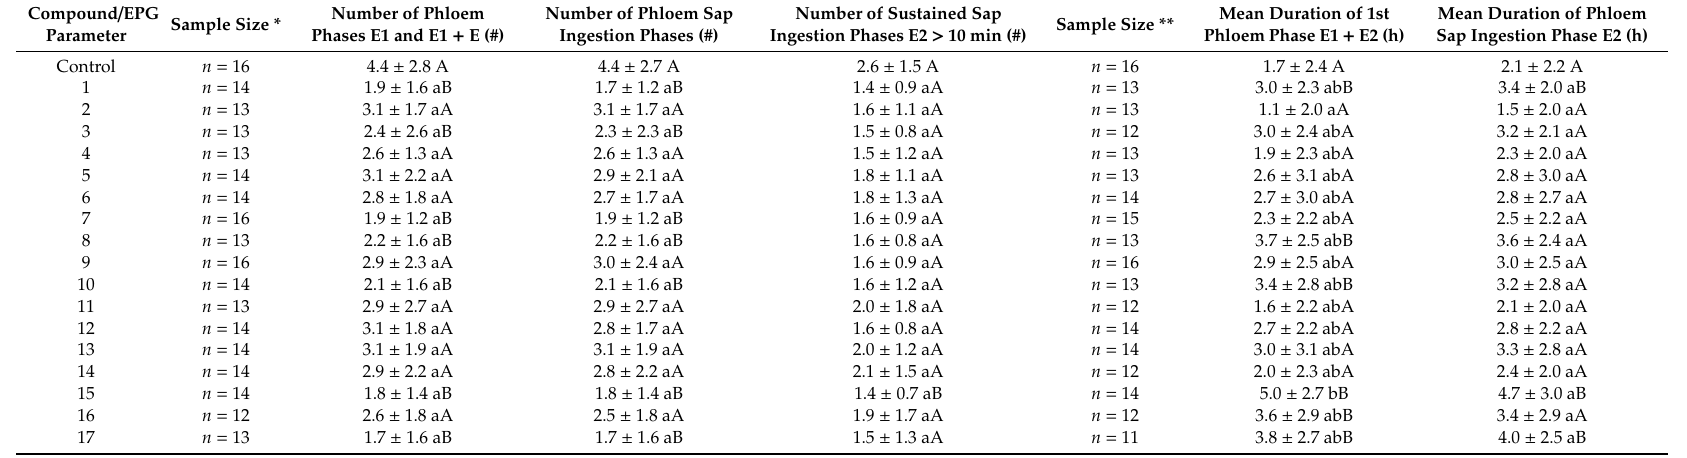
Table 3. Myzus persicae behavior associated with probing in sieve elements on naringenin and naringenin derivatives ( 1 – 17 , Figures 1 and 2)-treated plants (means ± SD); the mean and SD values given are a representation of non-Gaussian data, but the statistical analysis was done by non-parametric tests, in which all individual data were included; n —replication number; * all replications were included in analysis (the missing phloem phase was quantified as 0.0); ** aphids that did not reach phloem elements during 8 h experiment were excluded from this analysis; E1—phloem salivation; E2—phloem sap ingestion. Di ff erent small letters in columns show significant di ff erences in the values of specific parameters among aphids on plants treated with individual naringenin derivatives (Kruskal–Wallis test, p < 0.05); di ff erent capital letters show significant di ff erences in the values of specific parameters between aphids on plants treated with individual compounds and control (Mann–Whitney U-test, p <